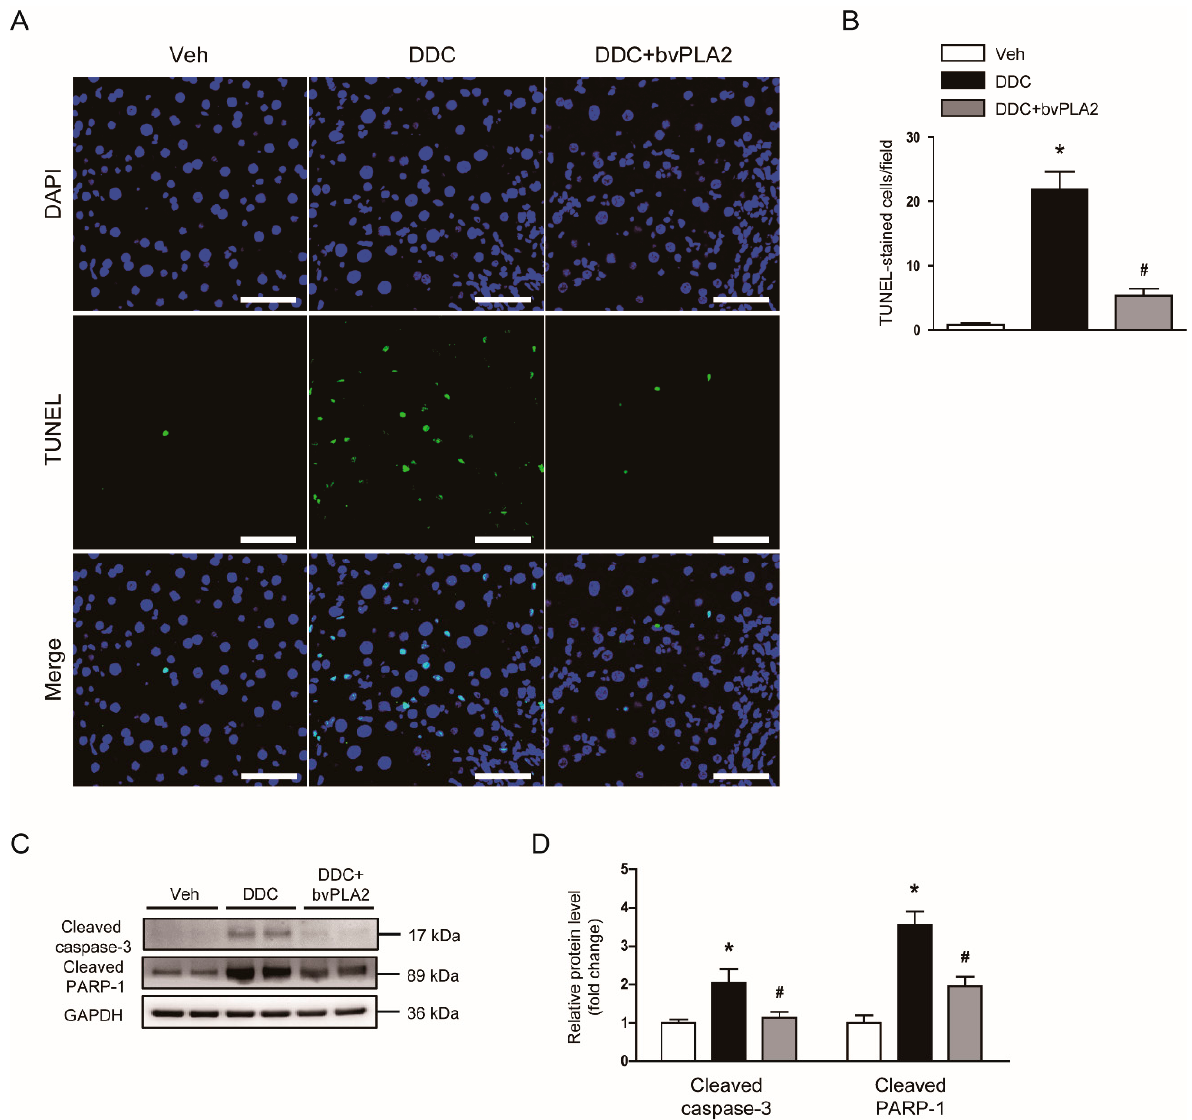
Figure 5. Effect of bvPLA2 on apoptotic cell death in DDC diet-fed mice. ( A ) TdT-mediated dUTP nick end labeling (TUNEL) assay on liver tissues. Scale bar = 40 μ m. ( B ) Number of TUNEL-stained cells. ( C ) Western blotting of cleaved caspase-3 and cleaved poly(ADP-ribose) polymerase-1 (PARP-1) in liver tissues. ( D ) Quantification of western blots for cleaved caspase-3 and cleaved PARP-1. n = 8 per group. * p < 0.05 vs. Veh. # p < 0.05 vs. DDC.